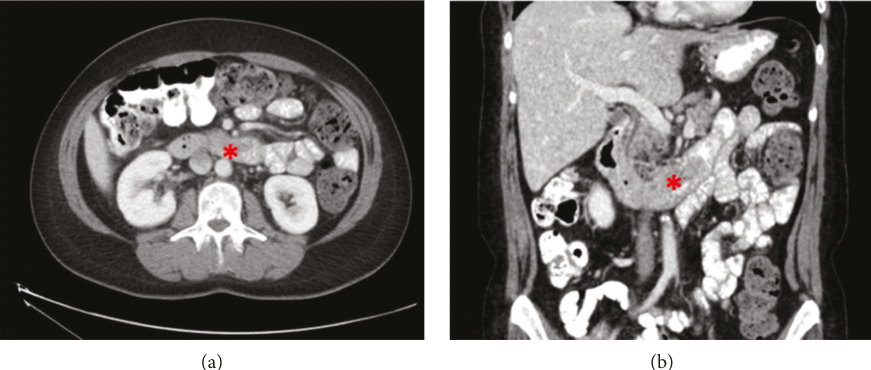
Figure 1: Axial (a) and coronal (b) computed tomography images of the duodenal GP, appearing as a hypodense lesion, shown to arise from the second/third portion of the duodenum and abut the uncinate process of the pancreas. Tumor is marked by an asterisk.